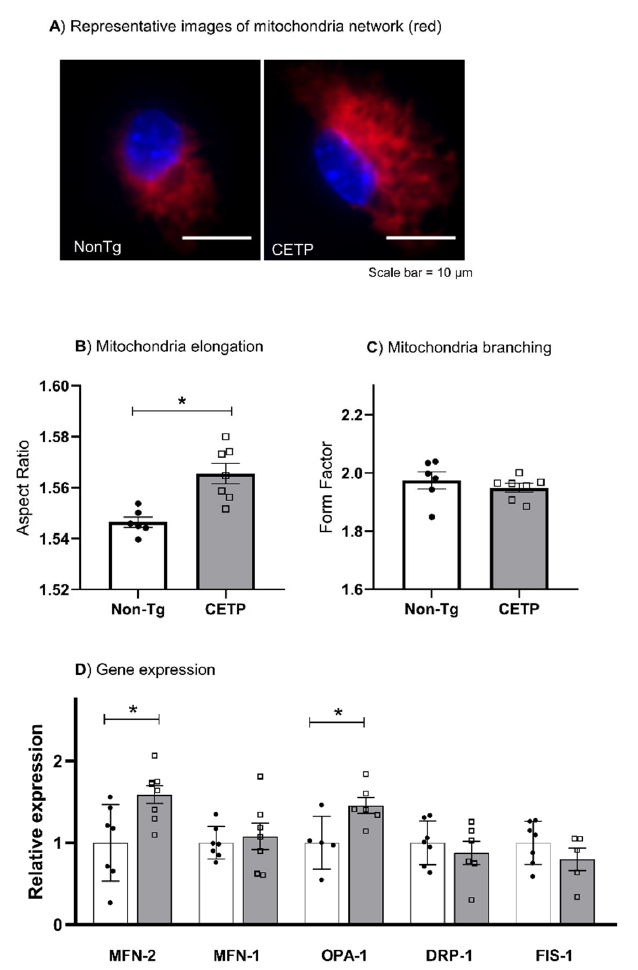
Figure 3. CETP expression in macrophages increases mitochondrial network elongation and the expression of fusion-related genes. Mitochondrial network morphology and gene expression were determined in thioglycolate-elicited peritoneal macrophages from human CETP-Tg and non-transgenic (Non-Tg) mice. ( A ) Representative images (60 × magnification) showing mitochondria stained with MitoTracker (red) and nuclei stained with Hoechst 33342 (blue). ( B ) The aspect ratio represents the degree of mitochondrial elongation and ( C ) the form factor represents the extent of network branching degree. ( D ) mRNA expression of the fusion genes Mitofusin-2 (MFN-2), MFN-1, and OPA-1, and the fission genes dynamin-related protein 1 (DRP-1) and mitochondrial fission 1 protein (FIS-1). * p < 0.05.